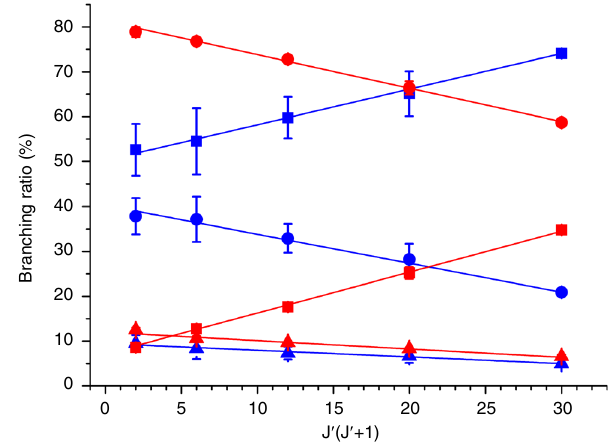
Fig. 3 Rotational dependence of the photodissociation branching ratios. Dependence of the branching ratios on J ′ (J ′ + 1) for the 1 Π (v ′ = 2) state of 12 C 16 O (blue) and 13 C 16 O (red) measured from the R-branch, J ′ is the rotational quantum number of the upper level. Square: C( 3 P) + O( 3 P); Circle: C( 1 D) + O( 3 P); Triangle: C( 3 P) + O( 1 D). The data of 12 C 16 O are adopted from ref. 32 . The error bars represent the standard deviation (1 σ ) of three independent